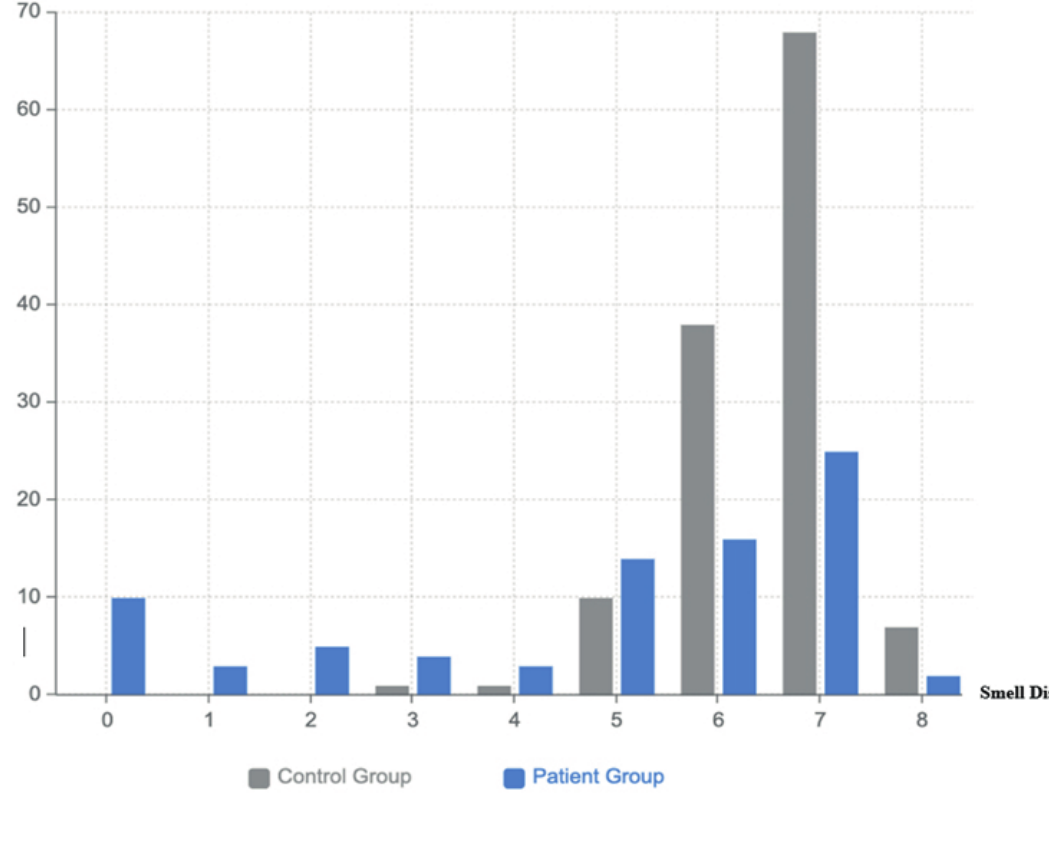
Figure 3. Smell Diskette Olfaction Test Scores of contral and patient